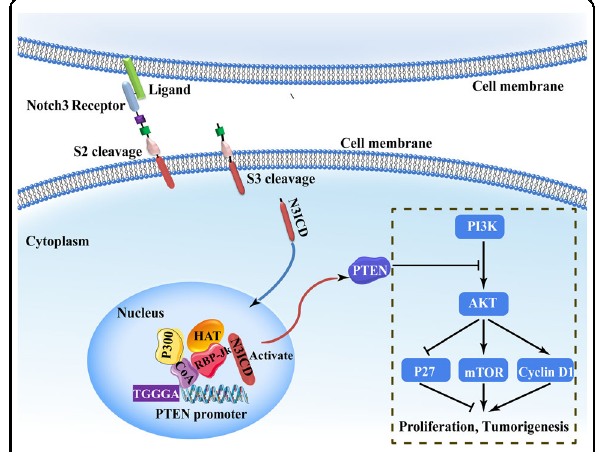
Fig. 7 A hypothetical model for the regulation of cell proliferation and tumorigenesis by the Notch3ICD/PTEN axis. Notch3 is subjected to S2 and S3 cleavage, which generates Notch3ICD. Notch3ICD binds directly to the CSL-binding elements in the PTEN promoter, resulting in transactivation of PTEN and its downstream signaling pathway and inhibition of breast cancer cell proliferation and